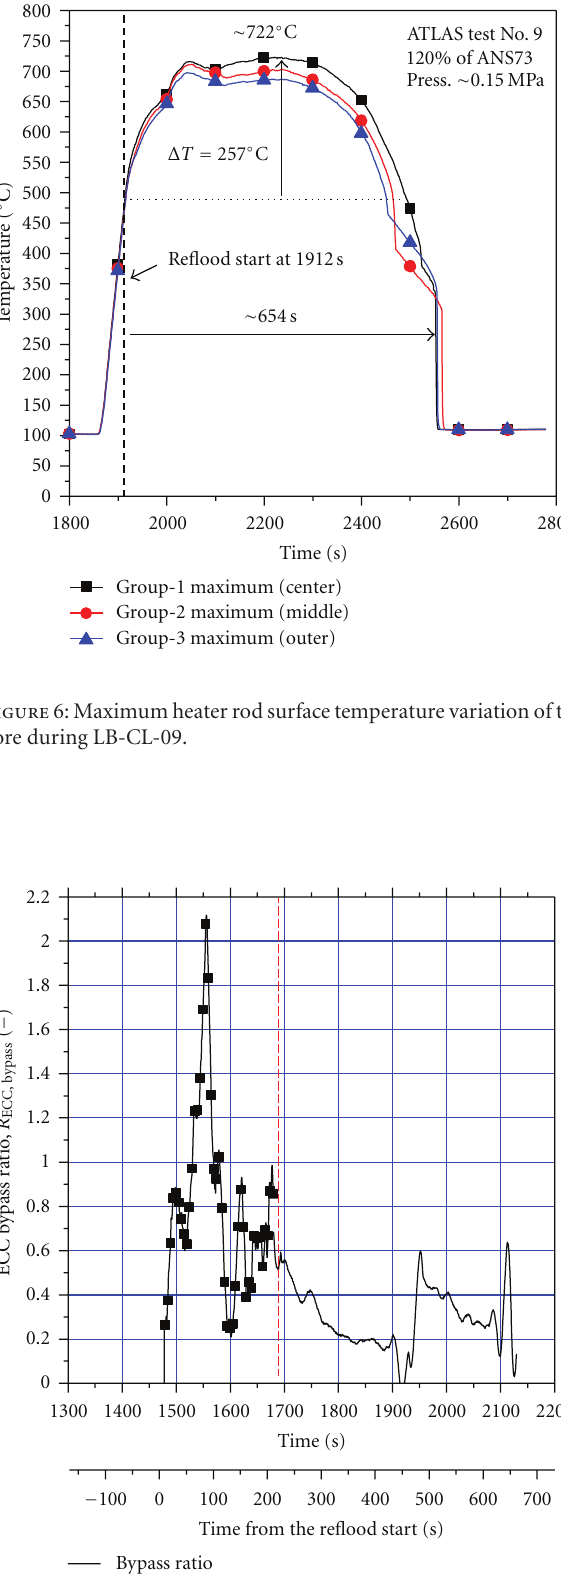
Figure 7: Comparison of estimated ECC bypass ratio with code calculations during LB-CL-11.